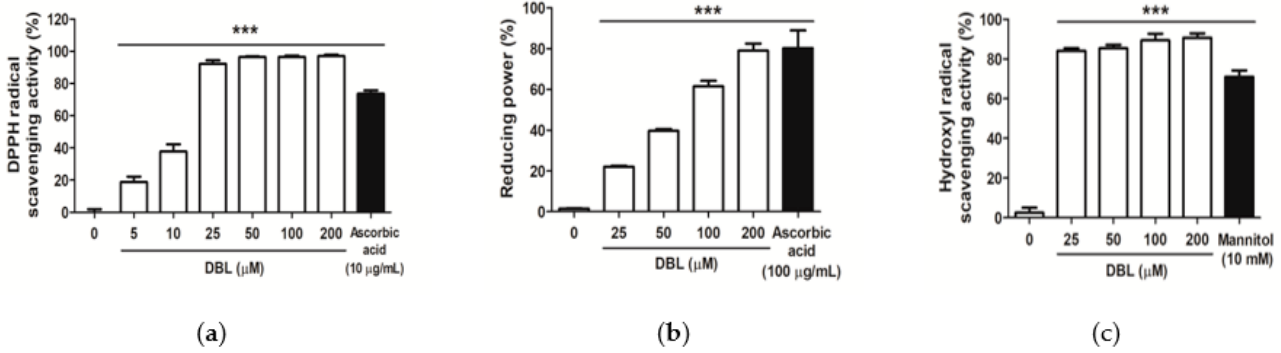
Figure 1. Antioxidative activity (%) of 3,4-dihydroxybenzalacetone (DBL). ( a ) 2,2-Diphenyl-1-picrylhydrazyl (DPPH) radical-scavenging activities, ( b ) reducing capacity, and ( c ) hydroxyl radical-scavenging activities. Each value has been presented as mean ± standard deviation (SD). Significant difference with control group: *** p < 0.001.